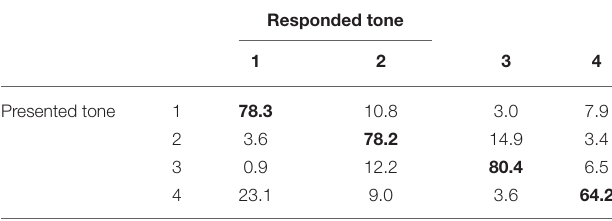
TABLE 1A | Confusion matrix for tone (percentage correct) in musicians.